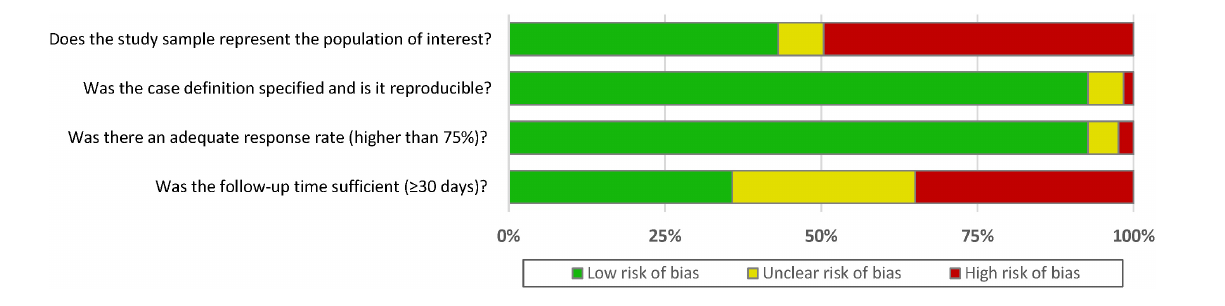
FIGURE 2 | Risk of bias